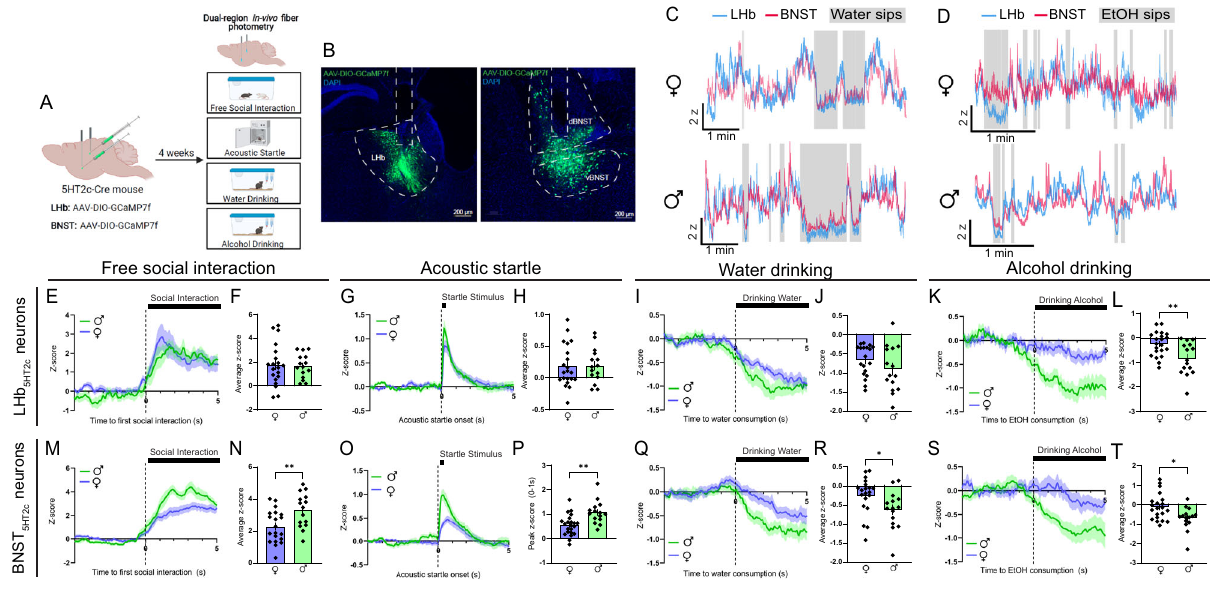
Fig. 1 | In-vivo LHb 5HT2c and BNST 5HT2c calcium signals are modulated by exposuretoaffectivestimuli.A ,Surgicalschematicandexperimentaltimelinefor GCaMP fi ber photometry experiments. B Representative viral infections and fi ber placements in LHb (left) and BNST (right).Similarviral placement was reproduced in n =37mice. C Representativetracesforwaterdrinkingsession(individualmice). D Representative traces for alcoholdrinking session(individualmice). E Peri-event plot of LHb 5HT2c GCaMP activity during the fi rst interaction with a novel juvenile social target (Females n =20 mice/1 trial; Males: n =15 mice/1 trial). F Average z-score of LHb 5HT2c GCaMP signalfor 0 – 5s post interaction (Females n =20 mice/1 trial,Males: n =15mice/1trial). G Peri-eventplotofLHb 5HT2c GCaMPactivityduring the acousticstartletest (Females: n =21mice/10 trials; Males: n =15 mice/10 trials). H Average z-score of LHb 5HT2c GCaMP signal for 0 – 5s post startle stimulus (Females: n =21 mice/10 trials; Males: n =15 mice/10 trials). I Peri-event plot of LHb 5HT2c GCaMP activity during voluntary water consumption (Females: n =21 mice/1-4bouts;Males: n =15mice/1 – 4bouts). J Averagez-scoreofLHb 5HT2c GCaMP signal for 0 – 5s post water drinking bout start (Females: n =21 mice/1 – 4 bouts; Males: n =15 mice/1 – 4 bouts). K Peri-event plot of LHb 5HT2c GCaMP activity during voluntary alcoholconsumption (Females: n =21 mice/1-4bouts;Males: n =15mice/ 1 – 4 bouts). L Average z-score of LHb 5HT2c GCaMP signal for 0-5s post alcohol drinking bout start, p =0.0038 (Females: n =21 mice/1-4 bouts; Males: n =15 mice/